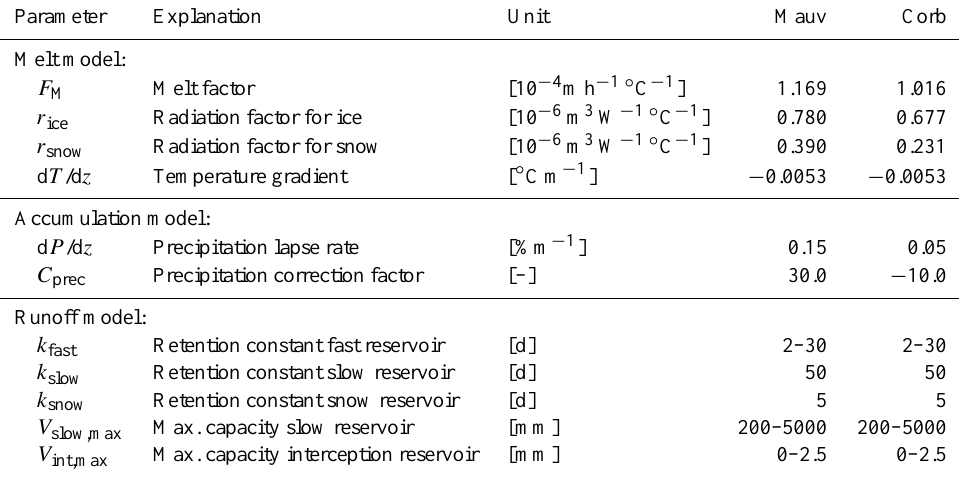
Table 4. Overview of the calibrated parameter sets of the melt, accumulation and runoff model shown for the two subcatchments Mauvoisin (Mauv) and Corbassi`ere/Petit Combin (Corb). The retention constants for the fast reservoir and the maximal capacity of the slow and the fast reservoir depend on the surface type (ice, snow, rock, low and high vegetation, open